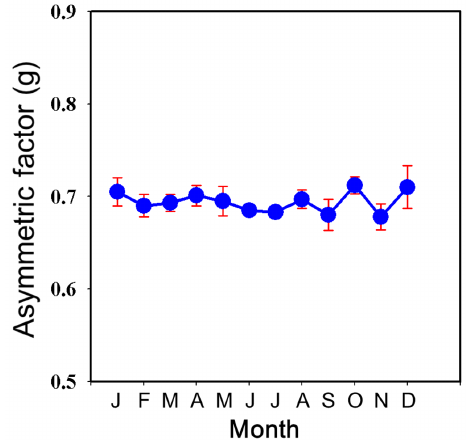
Fig. 3. Monthly averaged asymmetric factors (g) from nine AERONET sites for 2006. The red bars indicate ± σ (standard de- viation) of the AERONET asymmetric